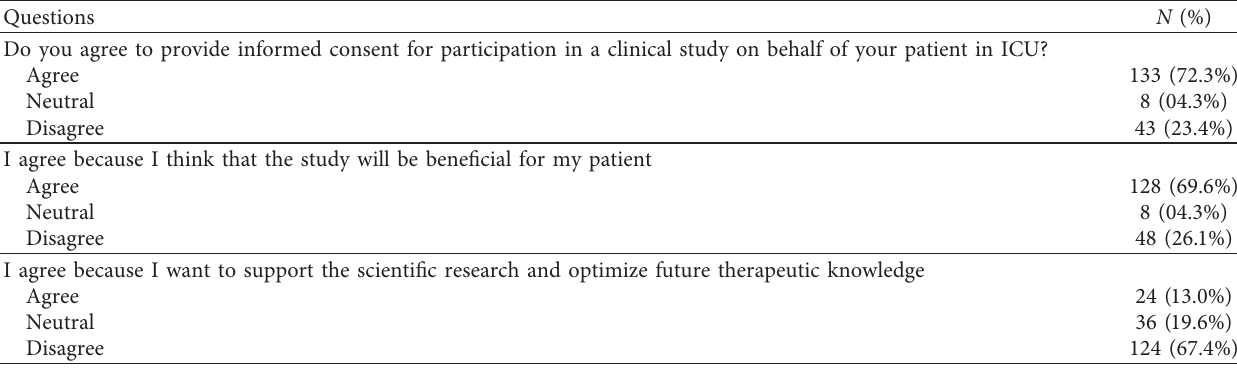
Table 3: Attitudes of ICU patient’s relatives toward informed consent according to their demographic factors. Demographic factors